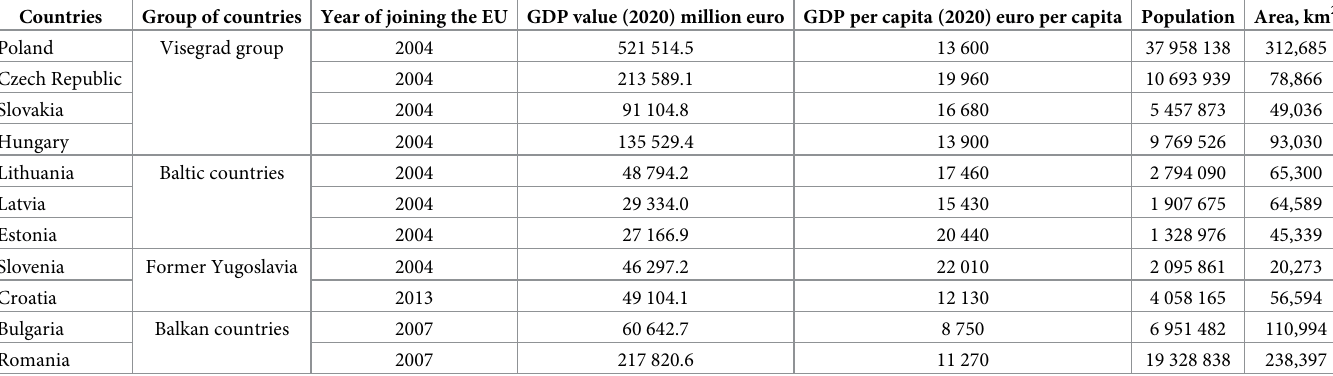
Table 4. Basic information about the CEE countries belonging to the EU (own elaboration based on [67]).